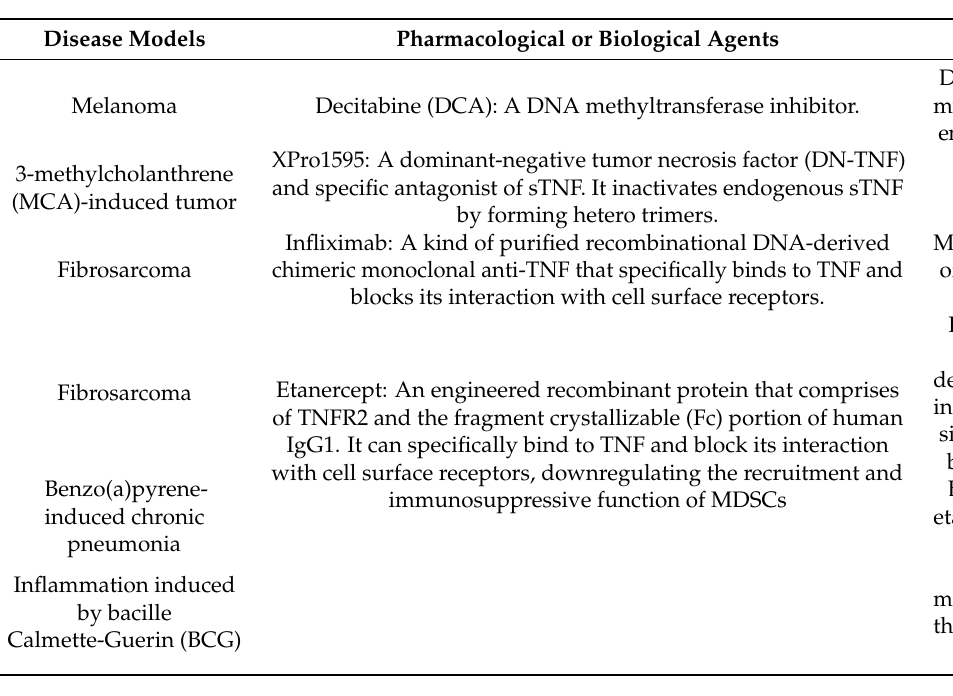
Table 1. The therapeutic roles of TNF signaling pathways in MDSCs to some